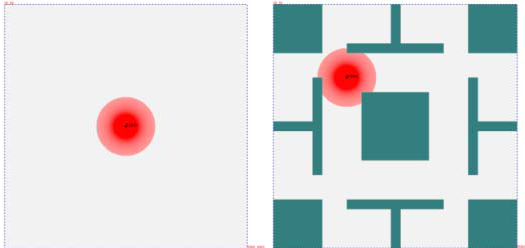
Figure 10. Two deployment areas used in the